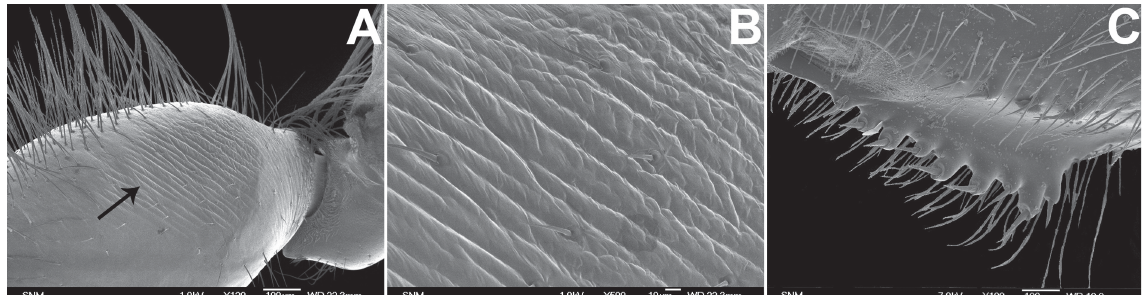
Fig. 5. Megatrigon spp., right wing, ♂. A . Megatrigon apiformis sp. nov. B . M. cooksoni sp. nov. C . M. tabanoides sp. nov.